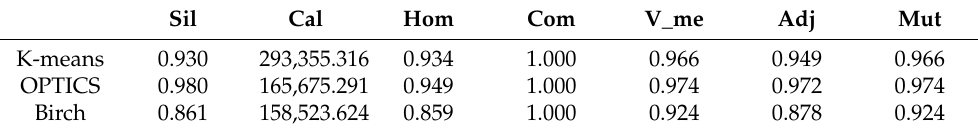
Table 3. Comparison of objective evaluation index results of different clustering methods.